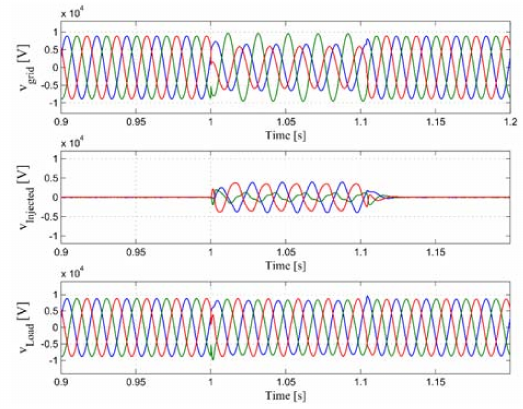
Figure 11. Case 2-Unbalanced voltage sag: grid voltage, injected voltage of the DVR and load voltage. DVR voltage injection restored the grid voltage almost perfectly for the load.